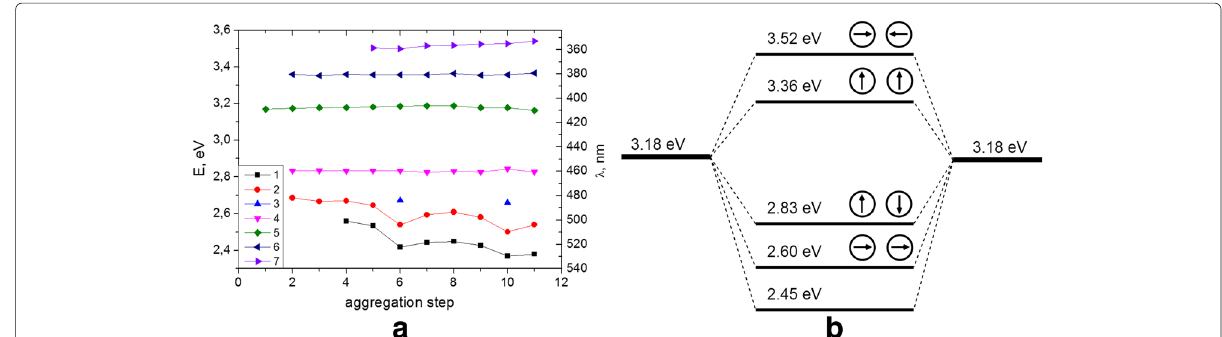
Fig. 6 a The spectral position of components at different stages of cluster formation. The numbers on the horizontal axis correspond to the numbers of curves in Fig. 5. b The hybridization scheme of plasmon modes in fractal